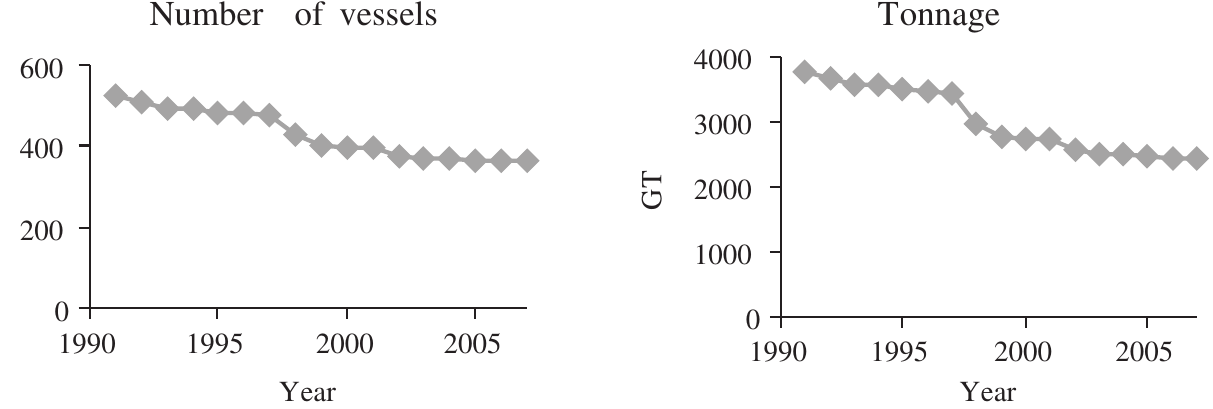
Fig . 2. – time series of the number of vessels with a boat seine license in Greece and their total tonnage, from 1991 to 2007 (Source: iMaS- Fish,